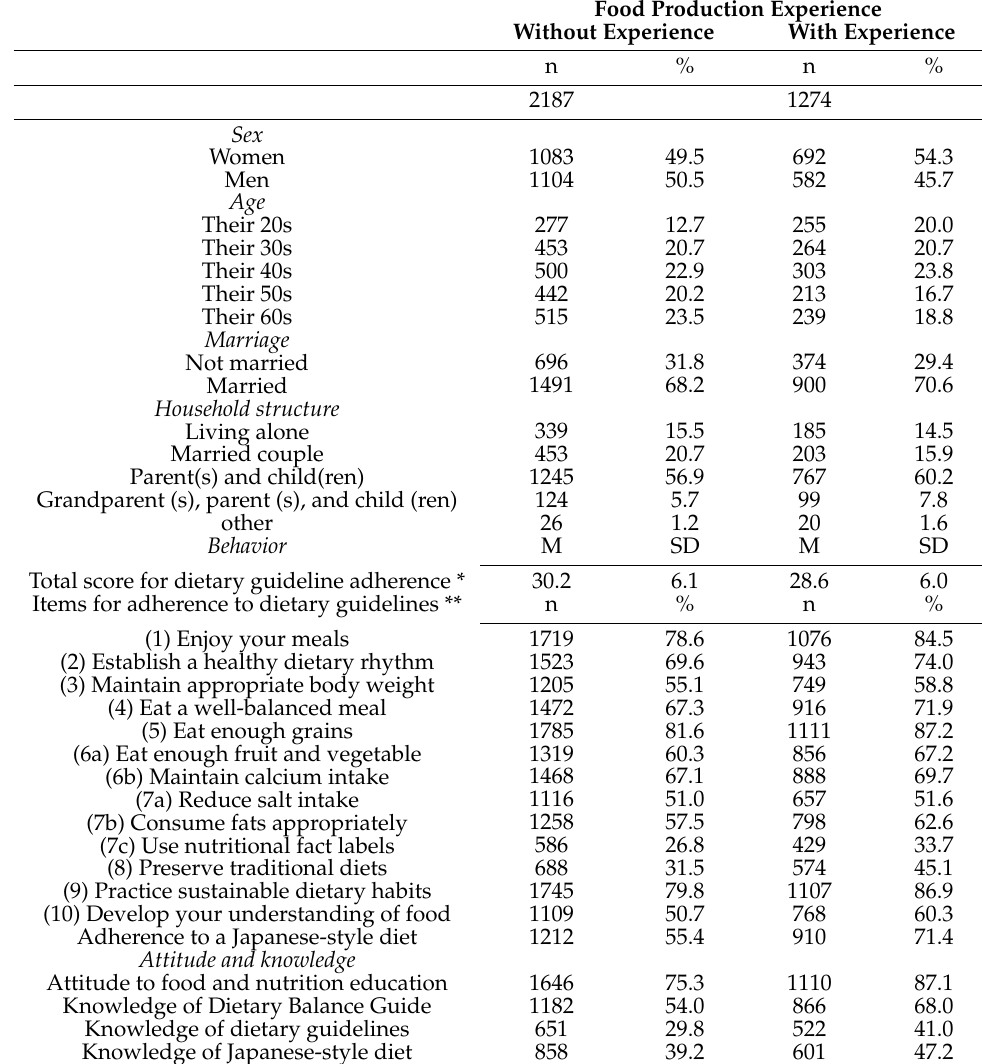
Table 1. Responses based on food production